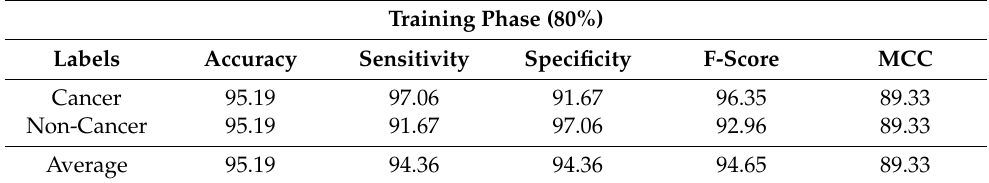
Figure 3. Confusion matrices of OIDCNN-OPMDD approach: ( a ) 80% of TR data, ( b ) 20% of TS data, ( c ) 70% of TR data, and ( d ) 30% of TS data. Table 2. Result analysis of OIDCNN-OPMDD approach with distinct class labels under 80% of TR data.